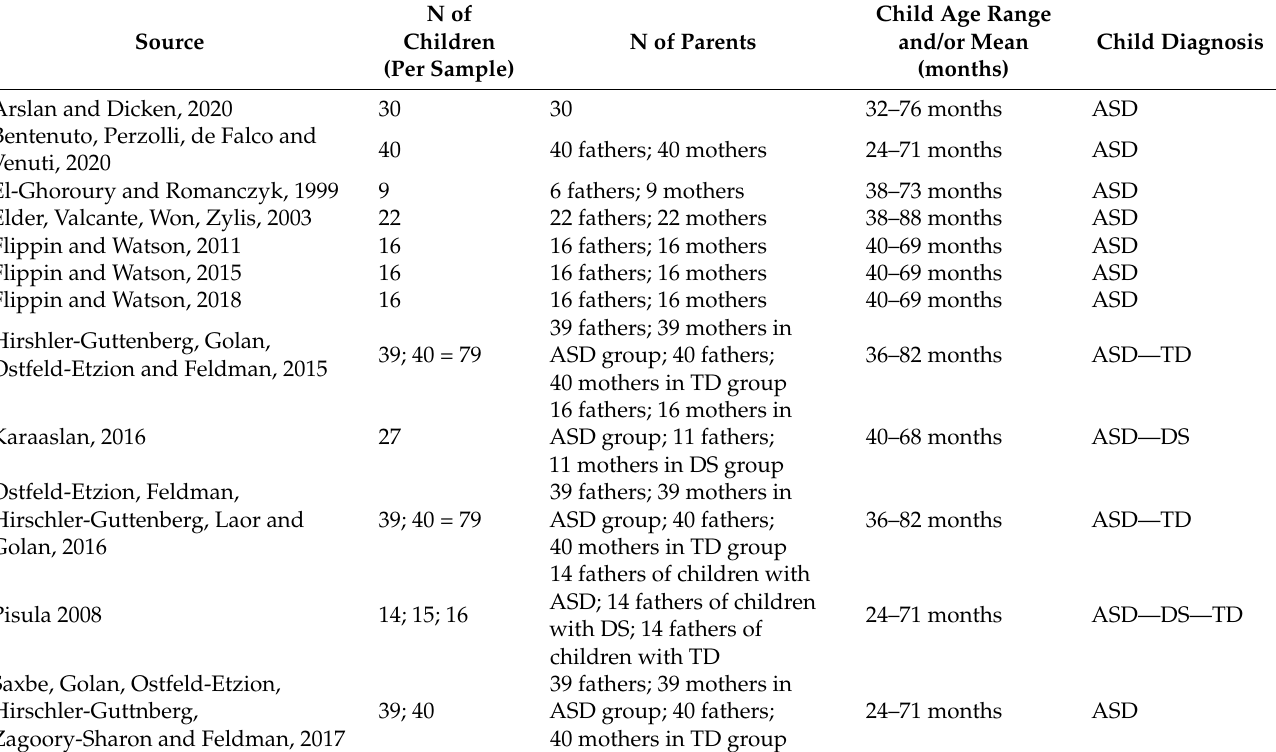
Table 2. Demographic Statistics of the